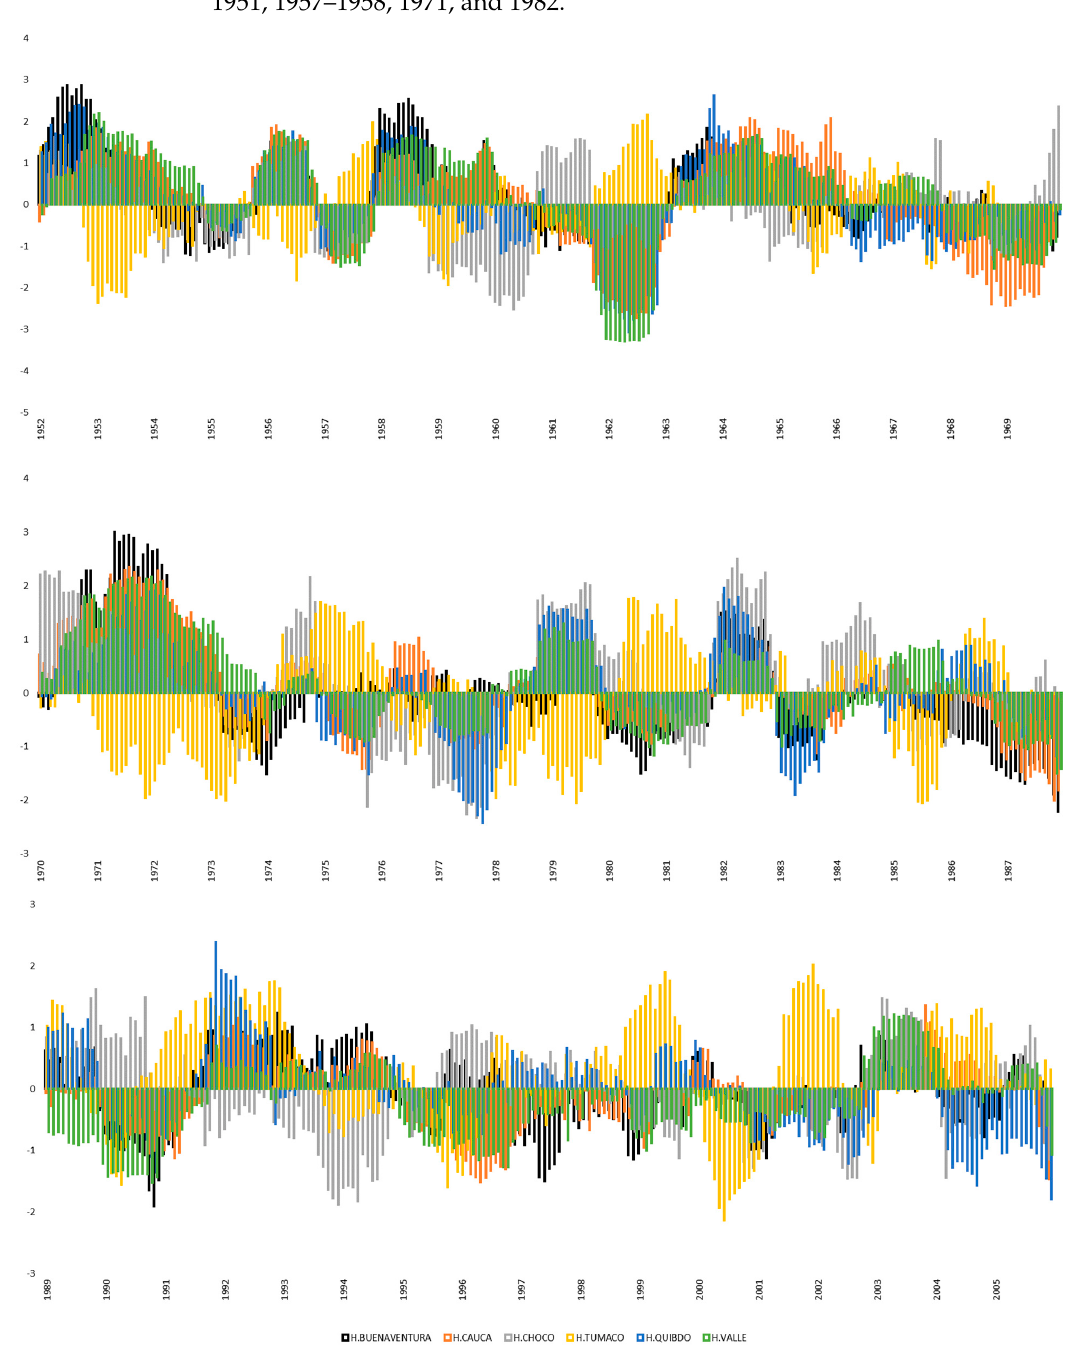
Figure 4. Twelve − month standardized precipitation index in Colombia’s Pacific region, 1951–